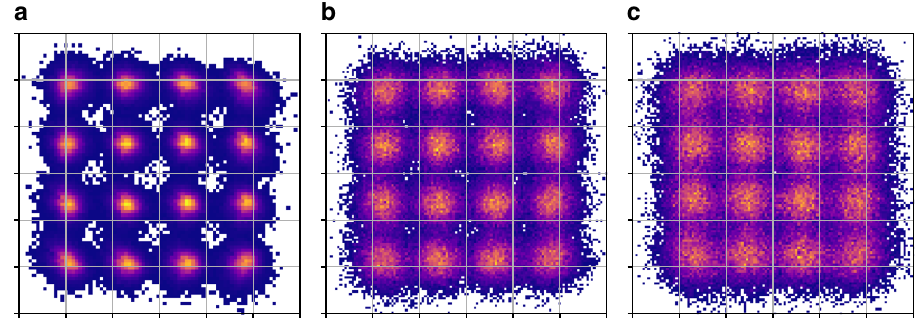
Fig. 8 Constellations. a Pre-distorted symbols at transmitter side; recovered constellation at the receiver b with and c without Tx-side NN-NLC. Received SNR = 18.4 dB after 2800 km transmission